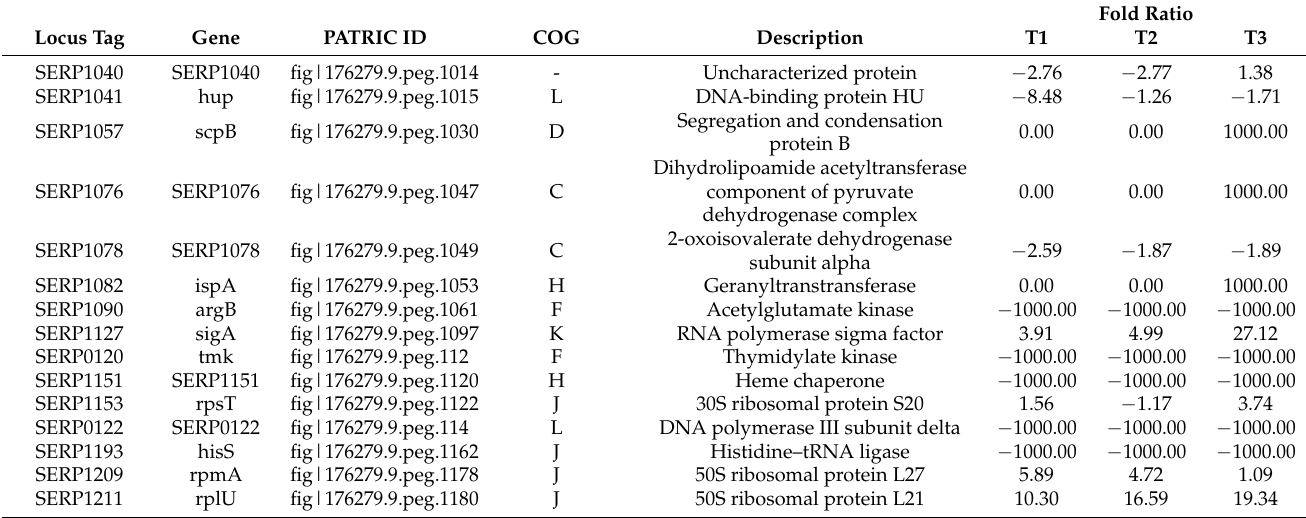
Table 10. Differentially expressed proteins associated with essential